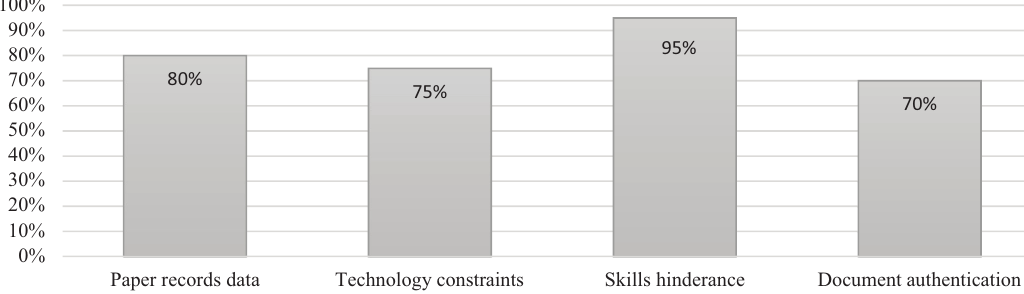
Figure 4. Staff response on system requirements